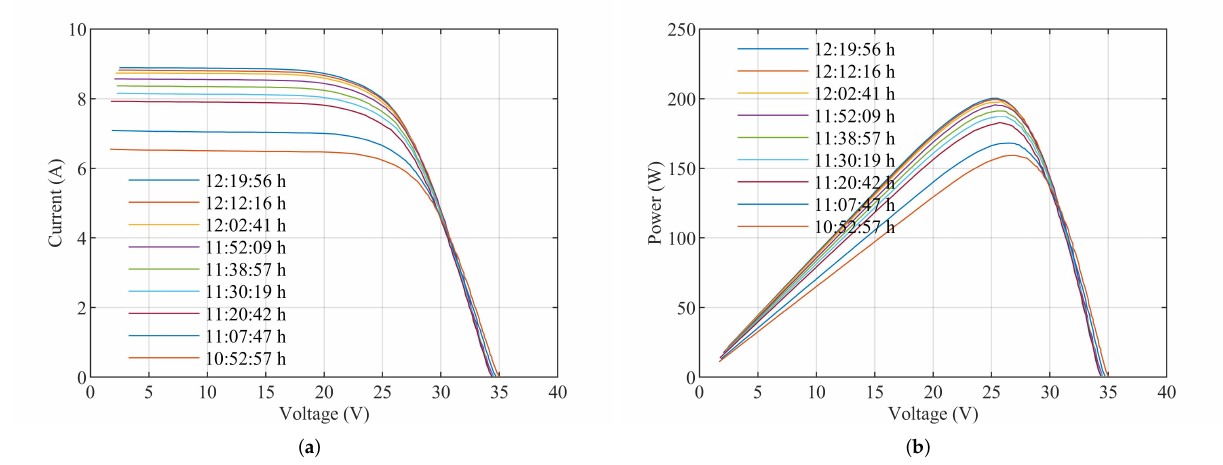
Figure 10. Temporal evolution of the ( a ) I–V and ( b ) P–V curves measured with chimney activated during 1 experimental